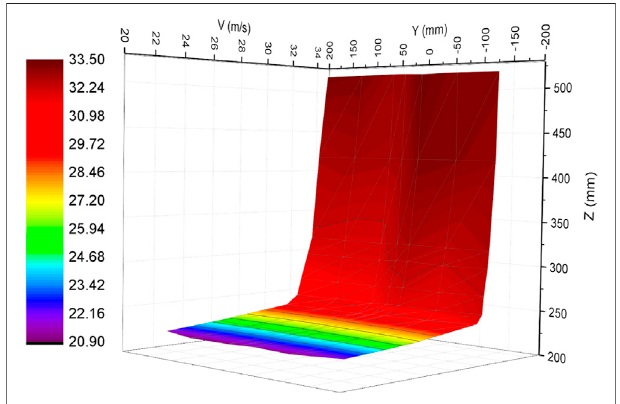
FIGURE 4 | Effects of incoming wind fi eld. V is the wind speed at the upwind cross section [Z ∈ (223, 518) mm and Y ∈ (-160, 160) mm].